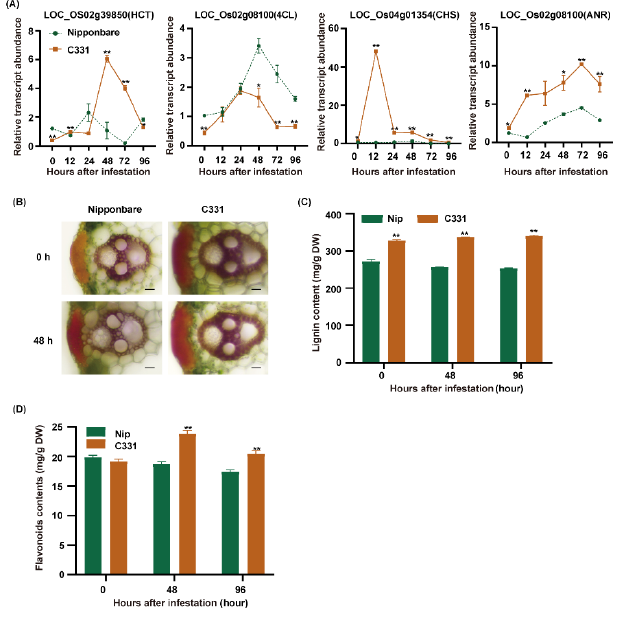
Figure 6. The gene expression and metabolites changes in the network of phenylpropanoid metabolism induced by BPH infestation. ( A ) Quantitative real-time PCR analyses of lignin and flavonoids biosynthesis pathway genes in Nipponbare and C331 attacked by BPH for 0 h, 12 h, 24 h, 48 h,72 h and 96 h. ( B ) Histochemical staining showing lignin accumulation in leaf sheaths fed by BPH for 0 h and 48 h (scale bars, 20 μ m). ( C ) Lignin contents of Nipponbare and the C331 plants fed by BPH for 0 h, 48 h and 96 h, measured using the acetyl bromide method. ( D ) Flavonoids contents of Nipponbare and the C331 plants fed by BPH for 0 h, 48 h and 96 h—*, p < 0.05; **, p < 0.01 by one-way ANOVA with Dunnett’s post-hoc test (C,D). All data are presented as the mean value ± SE. Phenylpropane biosynthesis can give rise to lignin by HCT and a series of enzymes, and flavonoid biosynthesis can give rise to flavonoids such as chalcones, leucoanthocyanidins and anthocyanidins by CHS and a series of enzymes [28]. To verify the